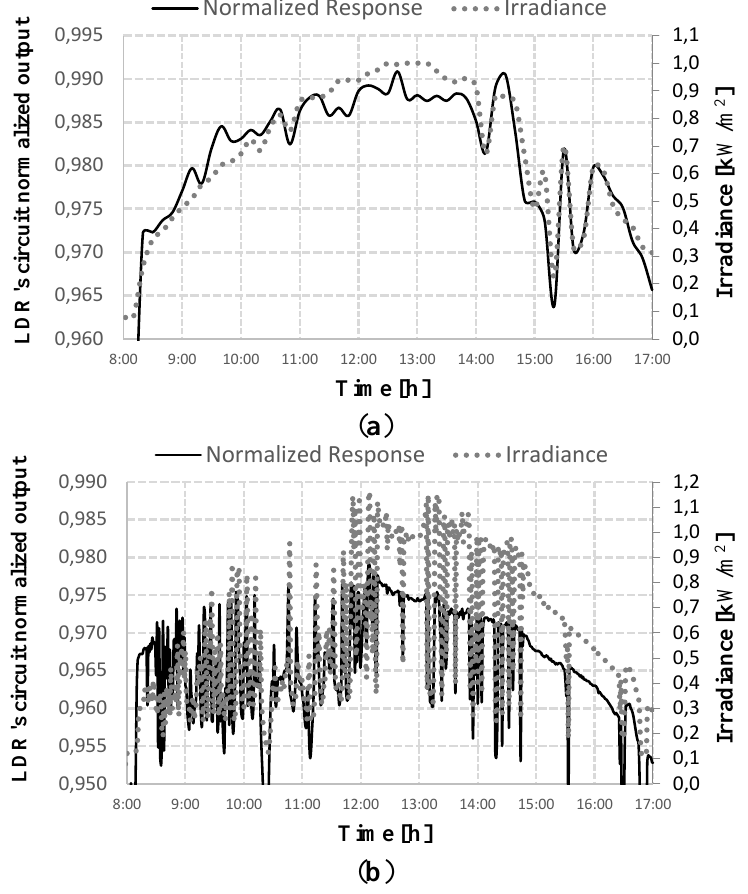
Figure 3. LDR normalized response, ( a ) sunny day and ( b ) cloudy